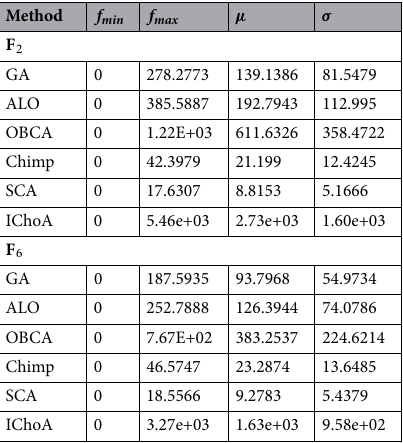
Table 9. Network life outputs of metaheuristics on F 2 and F 6 .